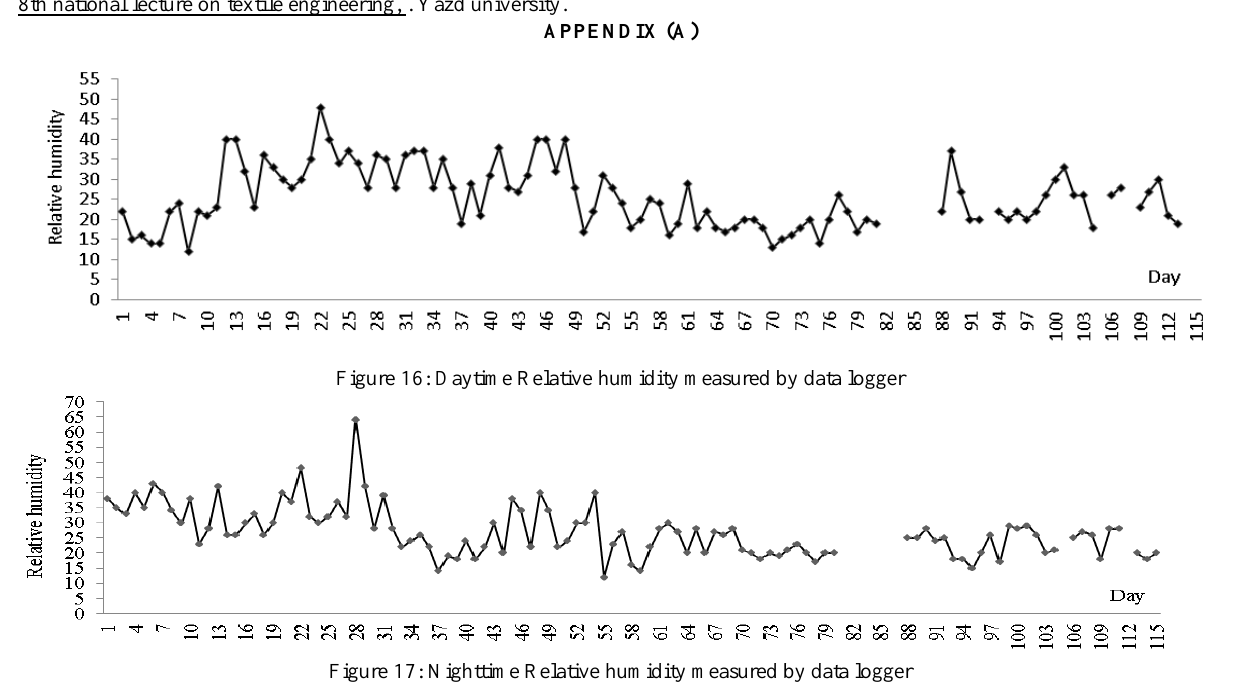
Figure 17: Nighttime Relative humidity measured by data logger